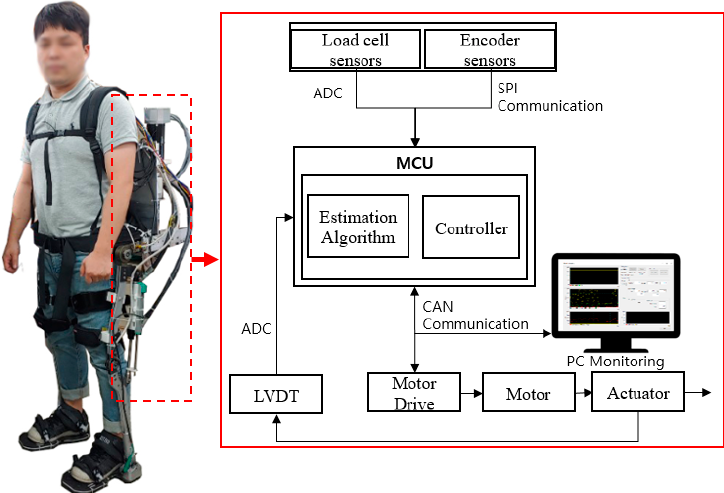
Figure 9. Schematic diagram of the experimental set-up for the exoskeleton system. ADC, analog-to- digital converter; CAN, controller area network; LVDT, linear variable differential transformer;